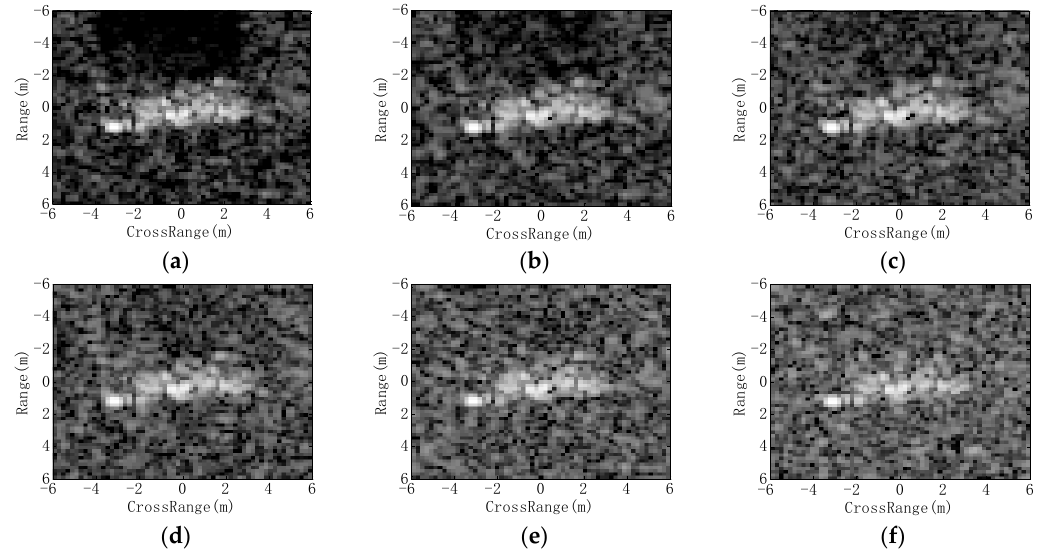
Figure 11. Images with noise addition (SNR): ( a ) original image; ( b ) 10 dB; ( c ) 5 dB; ( d ) 0 dB; ( e ) −5 dB; ( f ) −10 dB.